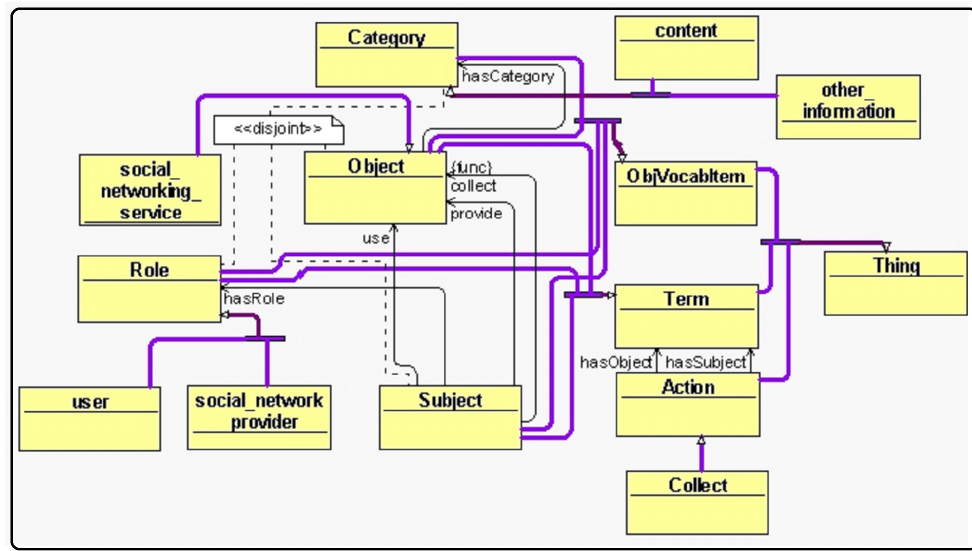
Figure 3. Ontology representation for